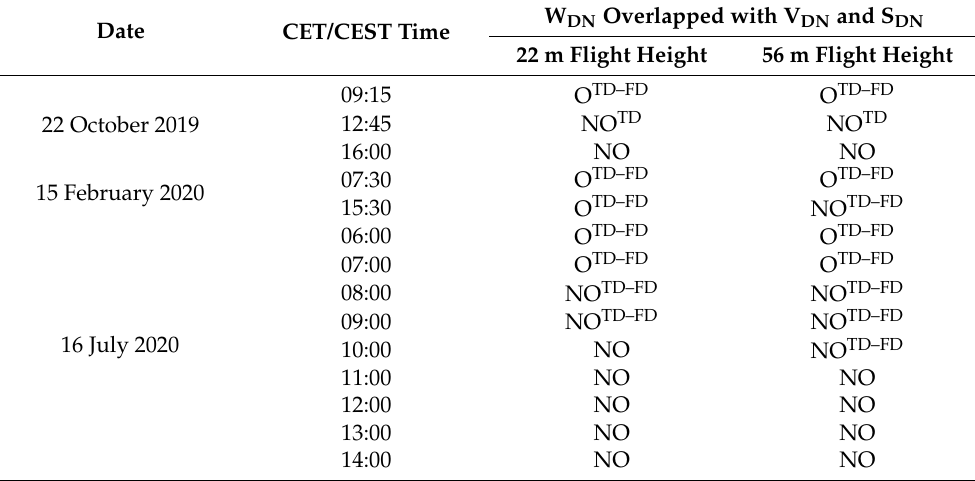
Table 4. Summary of the results concerning overlapping of W DN to V DN or S DN and true or false detection of water pixels outside the geomorphic channel. O: W DN overlapped; NO: W DN not overlapped. TD: true detection; FD: false detection. In some experiments both true and false water pixels were detected